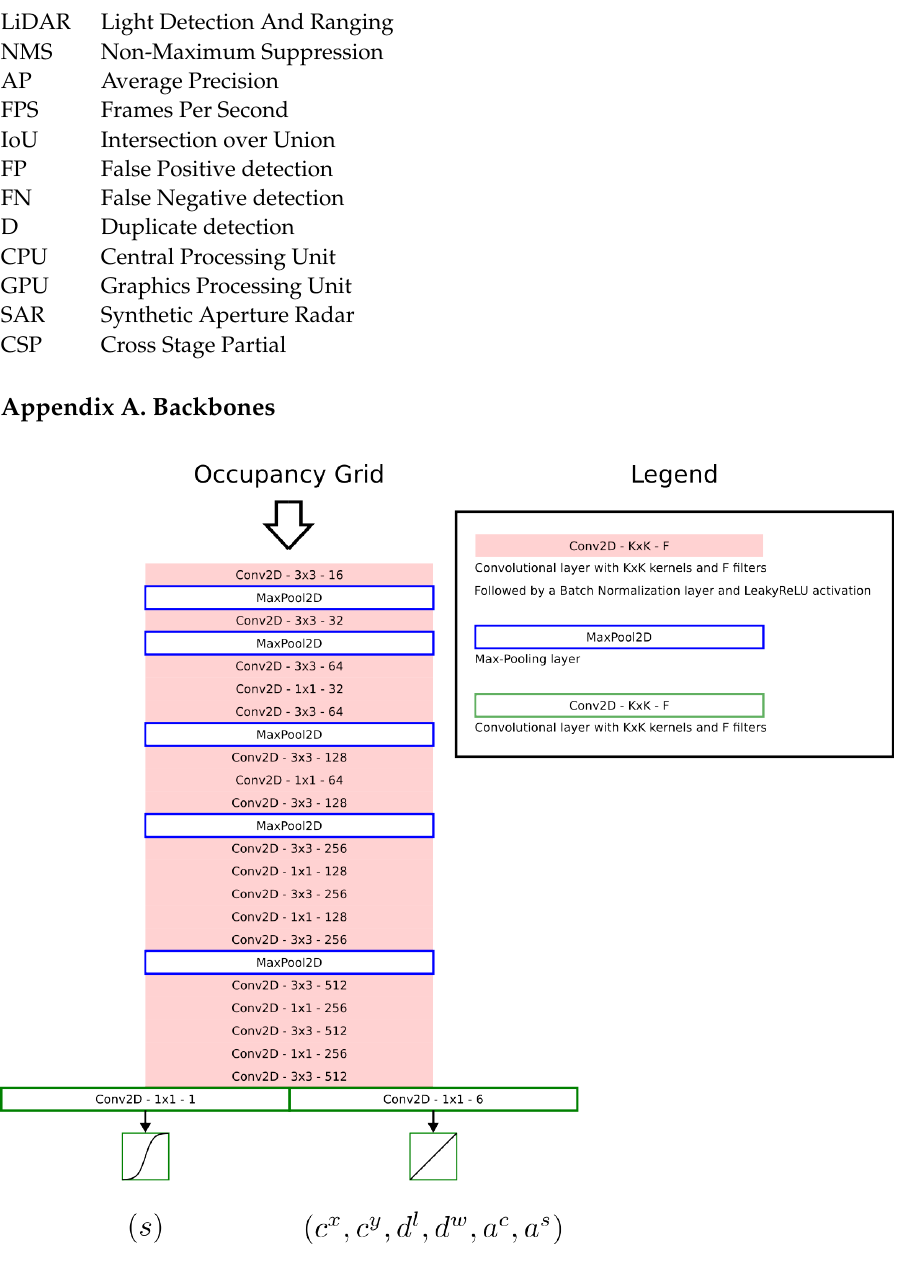
Figure A1. Architecture of GRID-YOLOv2 containing 4,961,463 trainable